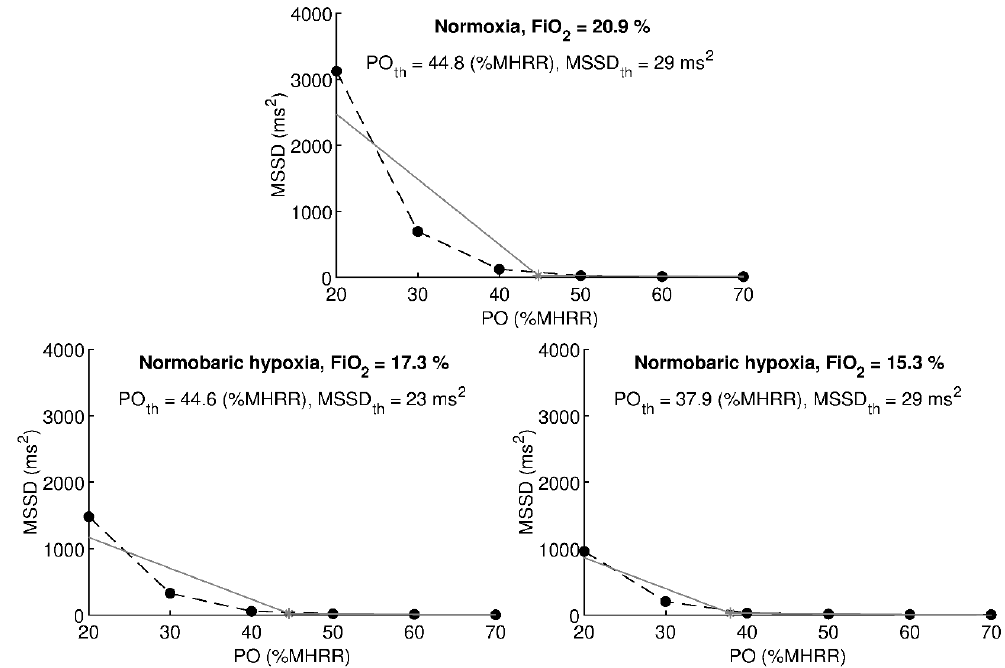
Figure 2. Illustrative example of calculating vagal threshold of one chosen participant at normoxia and two levels of normobaric hypoxia. Black circles and dashed line denote measured data. Grey lines denote regression lines. Grey asterisk indicates vagal threshold point. PO: power output corresponding to a percentage of maximal heart rate reserve in normoxia, MSSD: the mean of the squares of the successive differences between adjacent RR intervals, th: threshold.